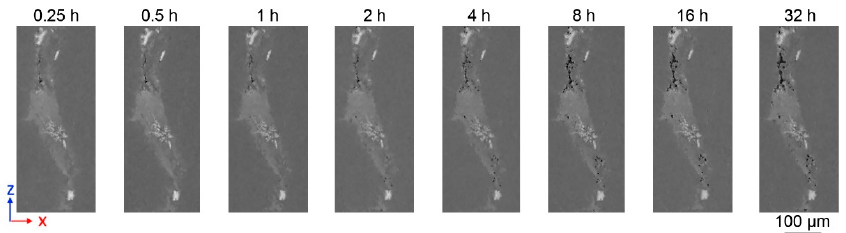
Figure 6. Evolution of a selected cluster of Kirkendall voids (marked by an arrow in Figure 5) during isothermal annealing at 450 °C between 0.25 h and 32 h.